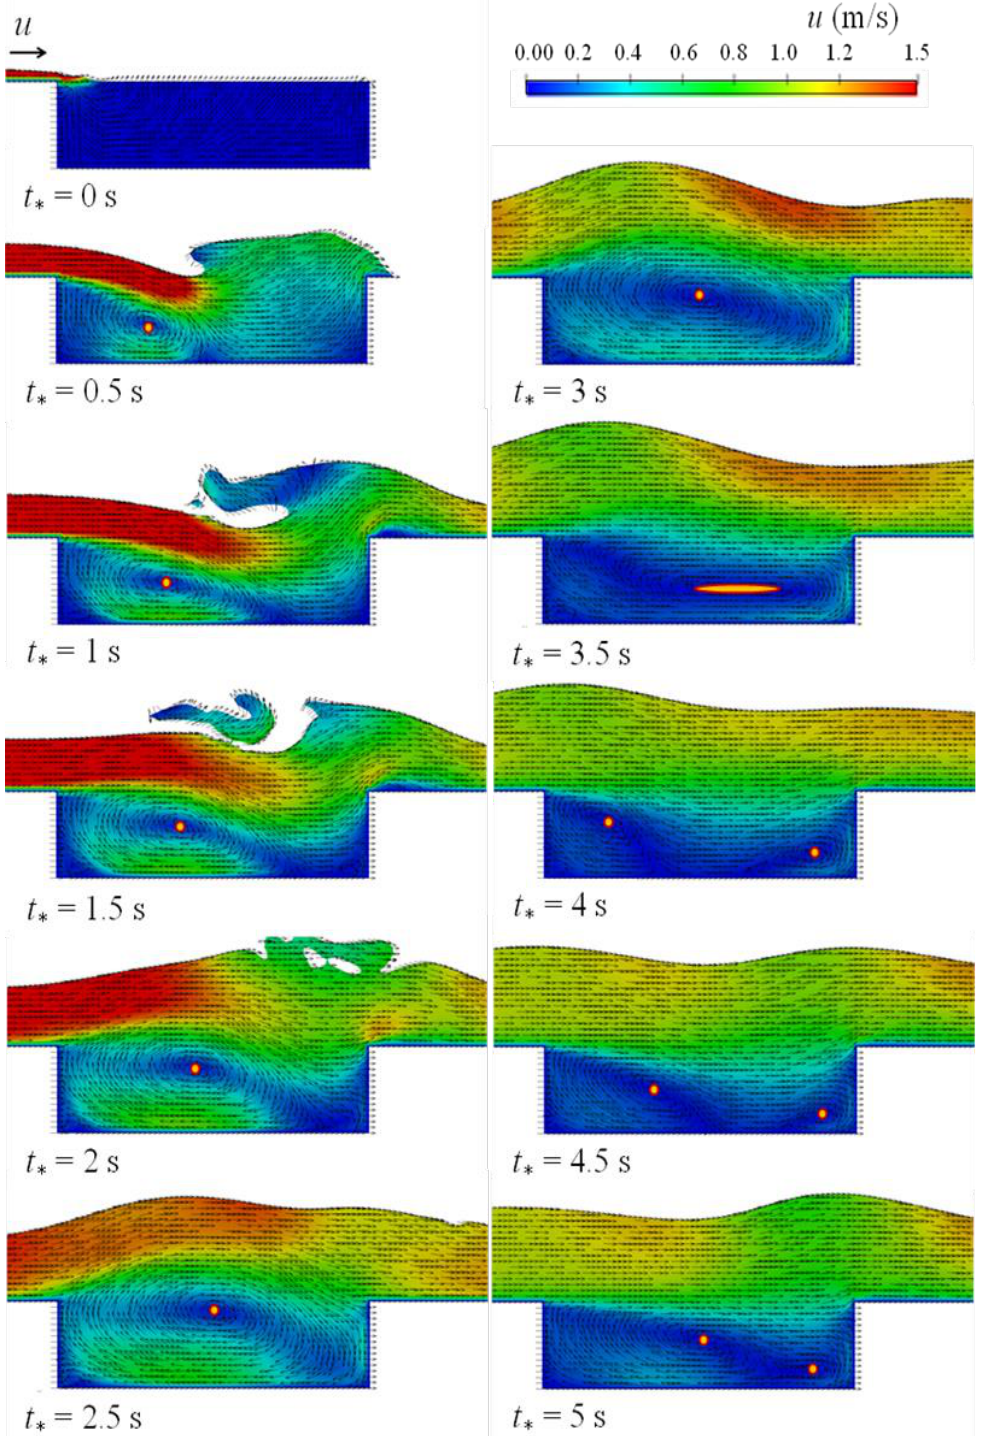
Figure 12. Variations of the contour plots of velocity and velocity vector fields with time, for a bore from an impoundment with a depth of d o = 0.3 m, passing over a canal with a width of w = 0.6 m and a depth of d = 0.15 m. The dots in the contour plots show the eyes of the vortices.